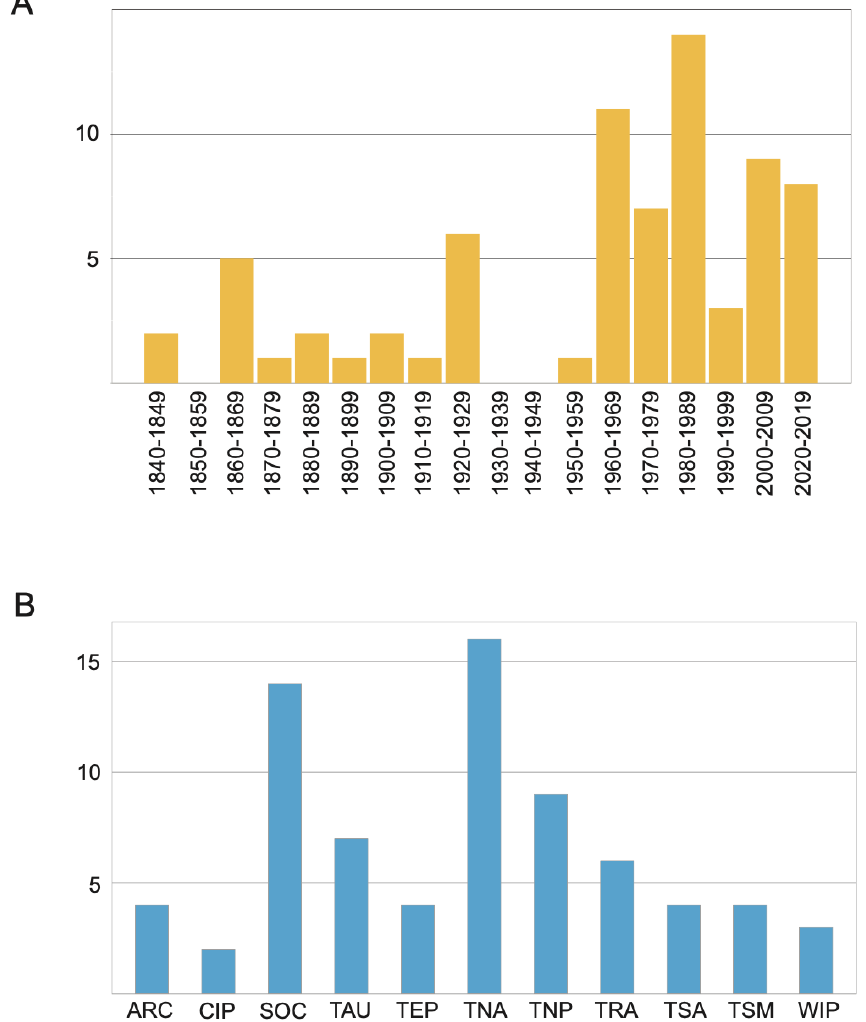
Figure 7. ( A ) number of scalibregmatid species described per decade; ( B ) number of valid scali- bregmatid species listed under the bioregion ( sensu Spalding et al. [45]) according to type